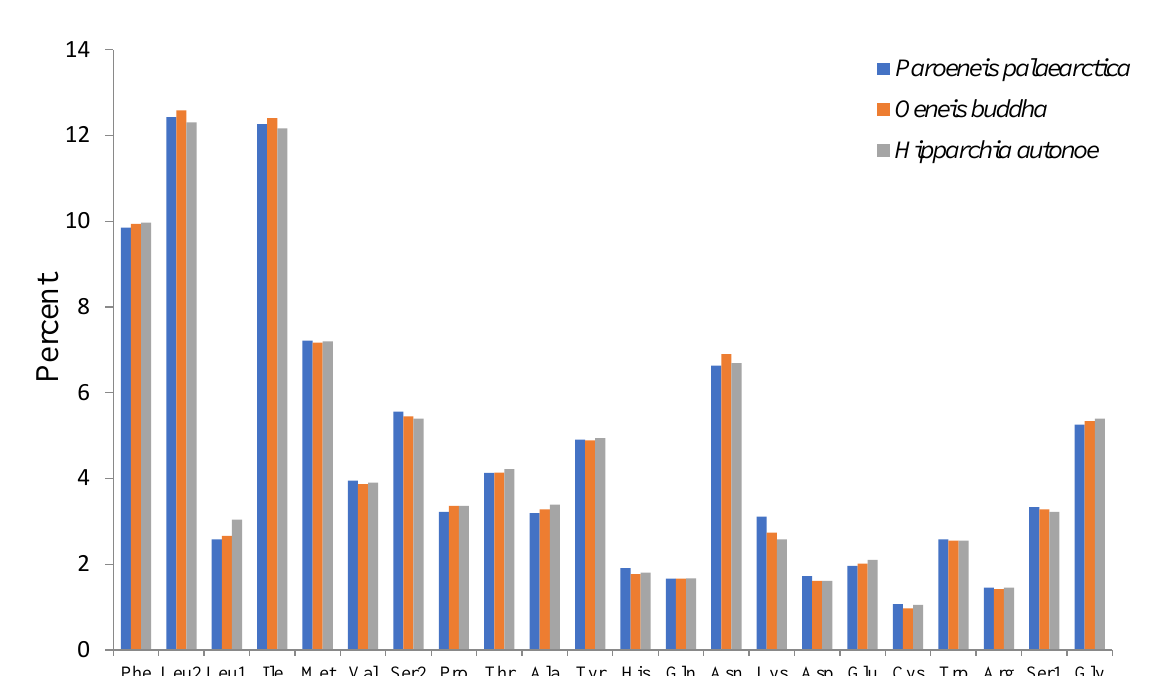
Figure 3. Composition of protein coding gene amino acids in the mitochondrial genomes.